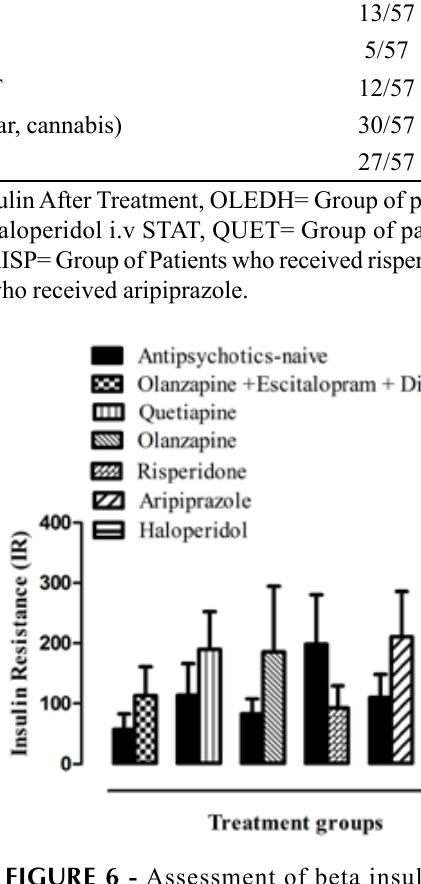
FIGURE 6 - Assessment of beta insulin resistance (IR): Antipsychotic-naïve patients were treated with olanzapine in combination with escitalopram, diazepam (STAT, I.V) and haloperidol (STAT, I.M) (OLEDH, n=8), quetiapine (QUET, n=8), olanzapine (OLAN, n=8), risperidone (RISP, n=8), aripiprazole (n=8) or haloperidol (n=8) in therapeutic doses for an average time period of 39, 40, 45, 38, 30 and 33 days respectively showing no significant change in IR as compared to antipsychotics-naive patients (ANOVA followed by Bonferroni’s Multiple Comparison Test) (P >